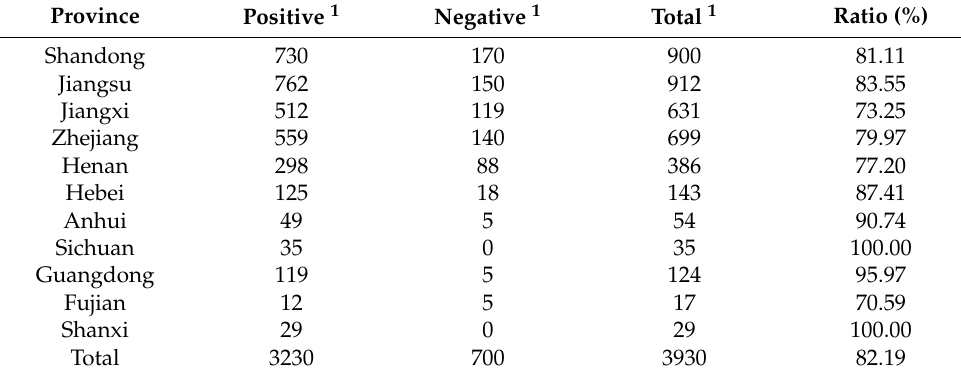
Table 3. The overall positive rate among different provinces.